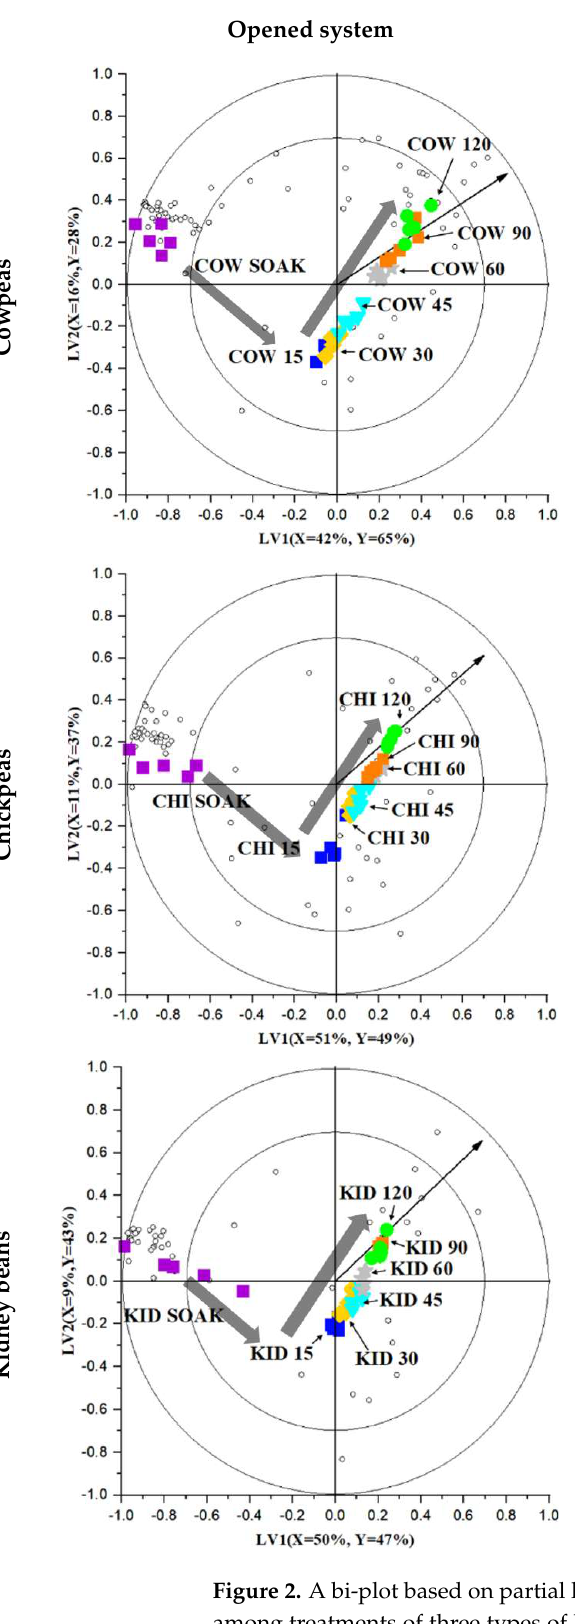
bi-plot, the coloured markers represent different sample treatments within a single leg- ume type, and the small unfilled circles represent the volatile compounds. Samples posi- tioned close to each other are considered similar (according to their volatile profile), and samples projected further from each other are considered to have a different volatile pro- file.